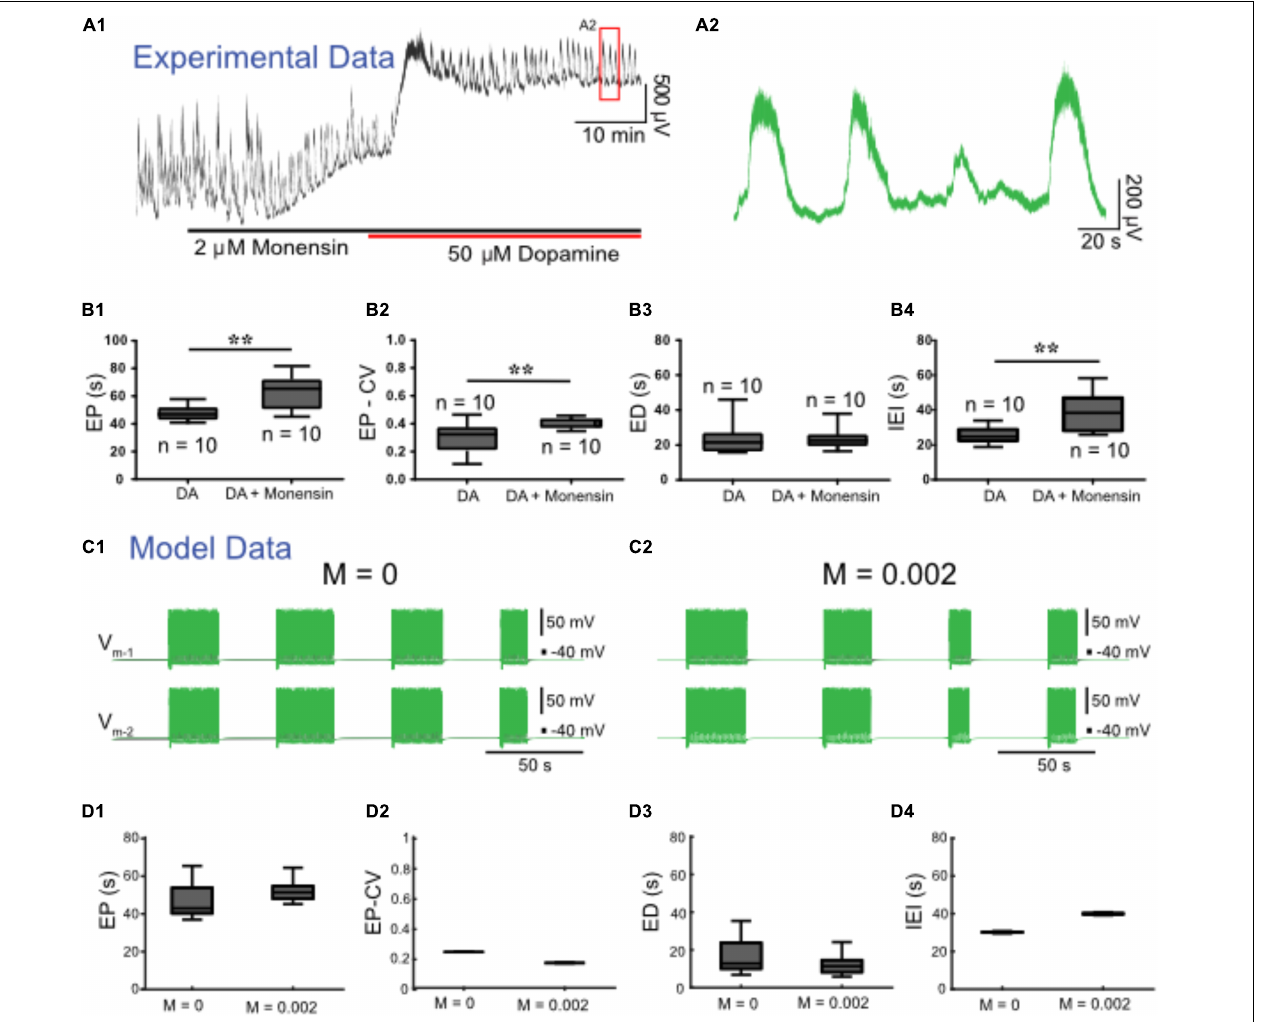
FIGURE 7 | Monensin increases episode period and interepisode interval in both modeled and experimental data. (A1) Extracellular neurograms recorded from ventral roots with bath application of 2 µ M monensin (black bar along the x -axis) followed by 50 µ M dopamine (red bar along x -axis). (A2) Expanded segment from inset (red box) in (A1) . (B1) Episode period (EP) increases with monensin (B2) but becomes more variable, (B3) while episode duration (ED) is maintained, and (B4) interepisode interval (IEI) is increased. Asterisks denote significance level following unpaired t -tests (DA: n = 10; DA+ Monensin: n = 10). We simulated monensin application in the model HCO by increasing the influx of intracellular sodium [Na + ] i using a monensin rate constant (M). Changing this rate constant from M = 0 (C1) to M = 0.002 (C2) in the model reproduced most of the effects of monensin on isolated spinal cords, leading to (D1) an increase in EP, (D2) decrease in EP-CV, (D3) no change in ED, and (D4) an increase in